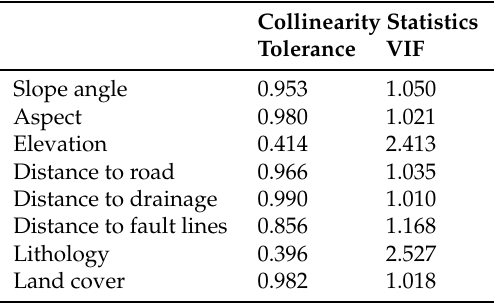
Table 3. Multicollinearity indices for causal